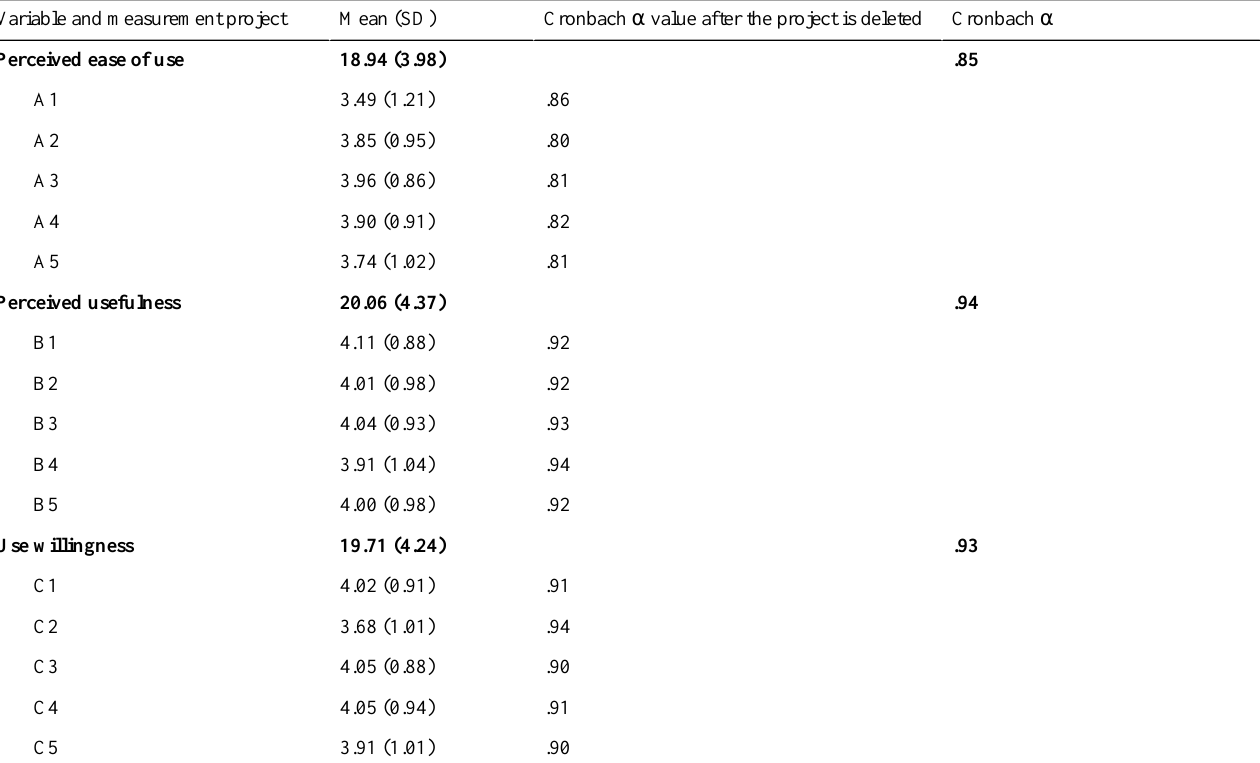
Table 2. Reliability, mean, and variance